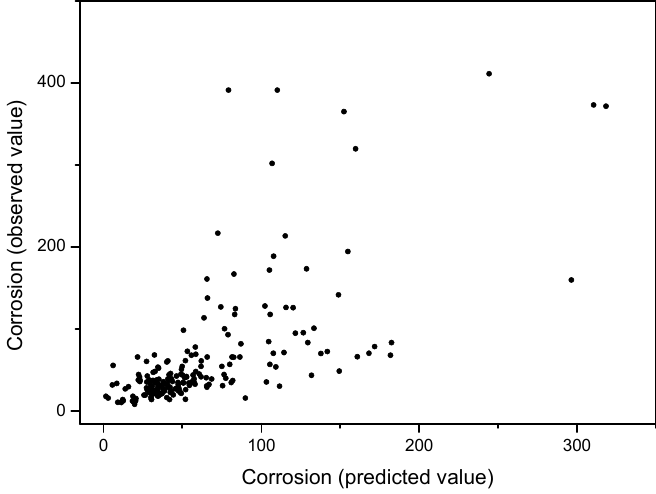
Figure 7. Relationship between predicted and observed carbon steel corrosion values by applying Equation (6).